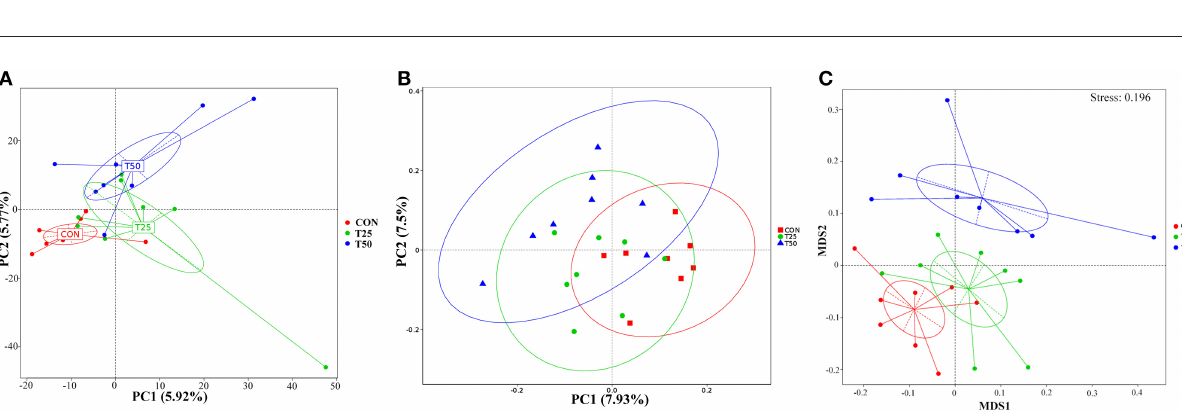
( ∼ 21% DM, 6% CP, 63% NDF, and 33% ADF) were lower than SPR ( ∼ 32% DM, 7% CP, 72% NDF, and 43% ADF).